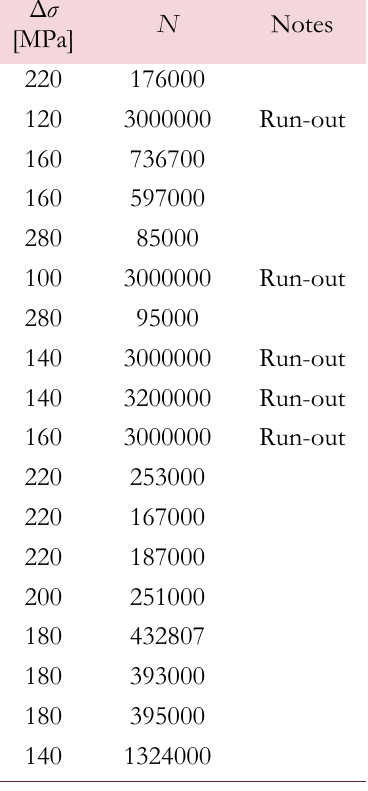
Table 2: Summary of all fatigue data from hot-dip galvanized bolted joints.